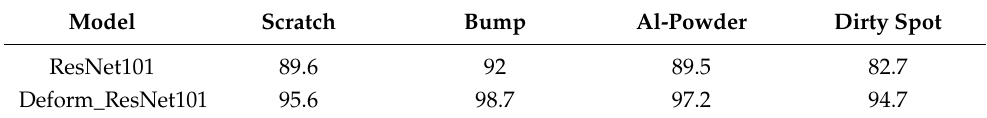
Table 6. Recall rate of model on validation set